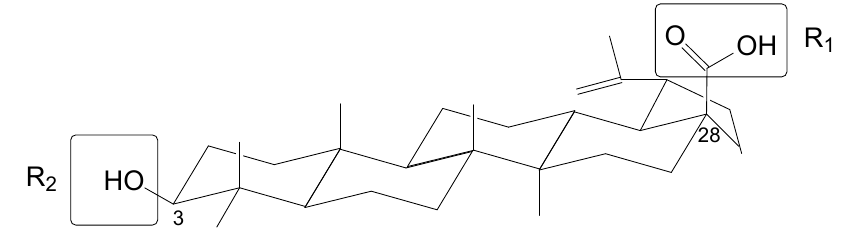
Figure 2. Diagram of split betulinic acid into three pieces for the topomer CoMFA